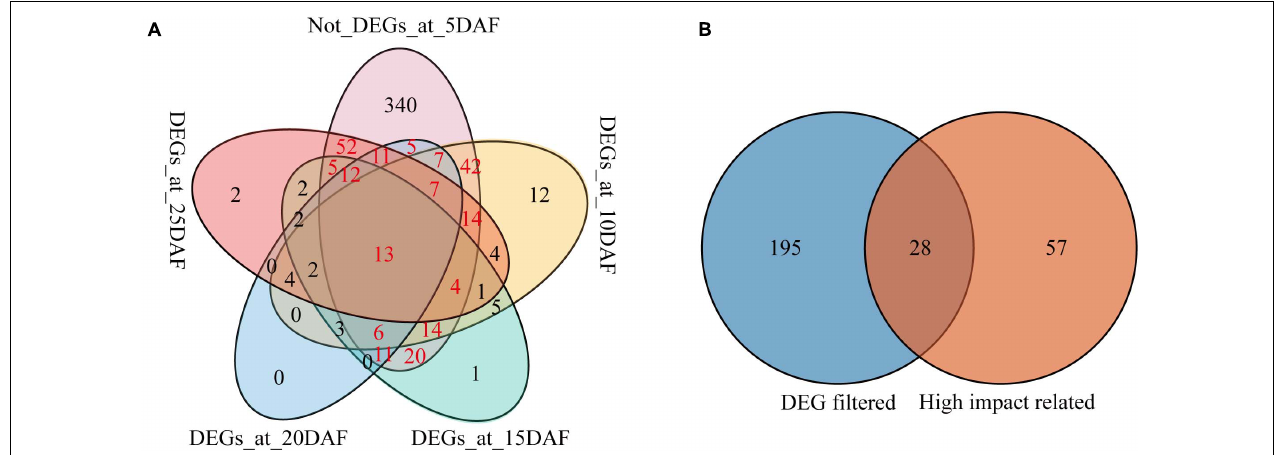
FIGURE 4 | Venn diagram of genes in the qSC intervals. (A) Venn diagram of the DEGs after 5 DAF and not-DEGs at the stage 5 DAF; (B) Venn diagram of the genes from DEG filtered (the genes that were DEGs in at least one of the stages 10, 15, 20 and 25 DAF but not at 5 DAF), and high-impact related (the genes containing high-impacts variants and co-segregated with the seed coat color